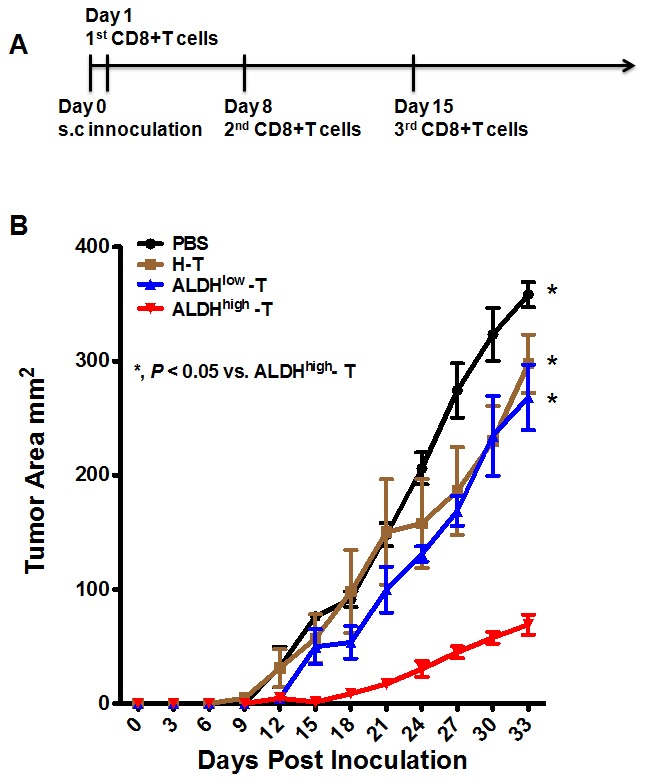
ALDHhigh-CD8+ T treatment inhibits subcutaneous tumor growth.(A) The treatment scheme. (B) The tumor sizes of the mice treated with ALDHhigh-CD8+ T cells were much smaller than the tumors of mice treated with PBS, H-CD8+ T, or ALDHlow-CD8+ T cells.